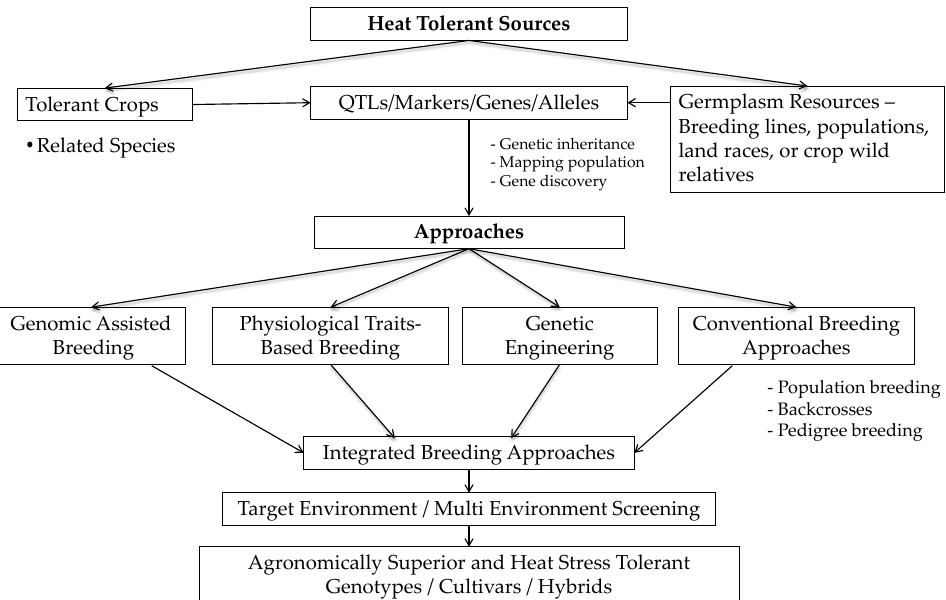
Figure 5. Proposed breeding approaches for development of sorghum heat (high) temperature (HT) stress tolerant cultivars (adopted from Govindaraj et al. [131]). Briefly, HT breeding requires HT sources from the breeding lines or germplasm collections from the source; dissecting HT trait genetics and inheritance in the future will guide the discovery of the candidate genes and loci (QTLs) in future. Identified sources/QTLs/genes can be transferred to elite cultivars that require HT for wider cultivation. To date, no straightforward breeding approach is available for HT. The proposed model is a combination of pre-breeding to product development. Breeding approaches will depend on the mode of trait inheritance (few/major genes or many/minor genes) in conventional breeding or physiological traits-based breeding methods. Genomic approaches will assists the breeding HT sorghum through advanced markers association studies, diagnostic markers, whereas, genetic engineering method helps in gene editing, provided a key candidate gene is identified for HT in sorghum. The reported 26 QTLs for HT in sorghum can be validated and used in